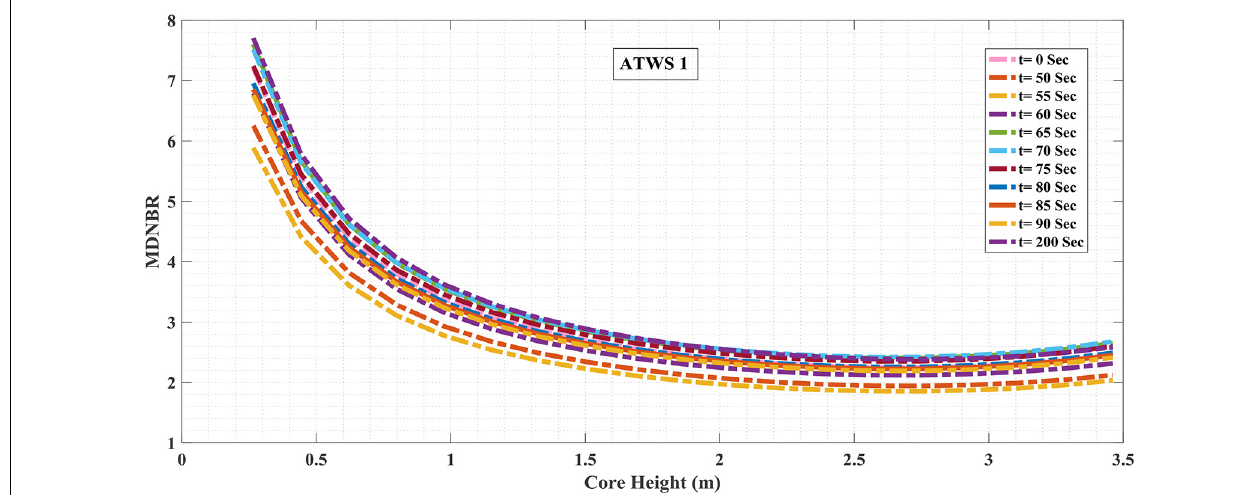
FIGURE 12 | MDNBR in core heights during ATWS 1.